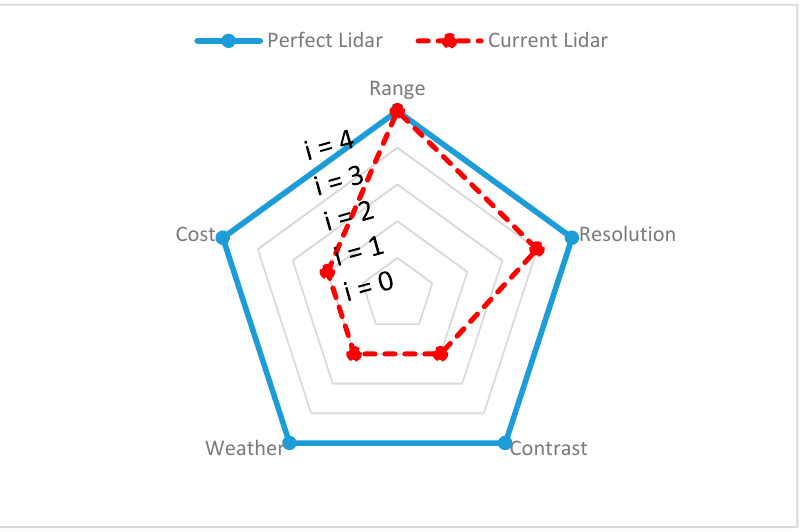
Figure 5. The performance gaps in lidar sensors are illustrated using a spider chart, based on performance scores.